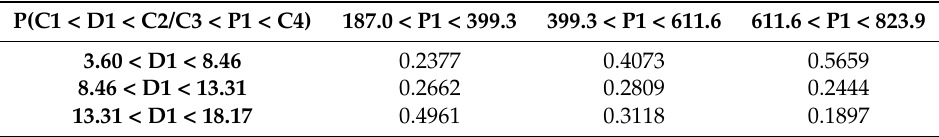
Table 6. Conditional probability of buried depth falling into different ranges given the condition of annual precipitation in different